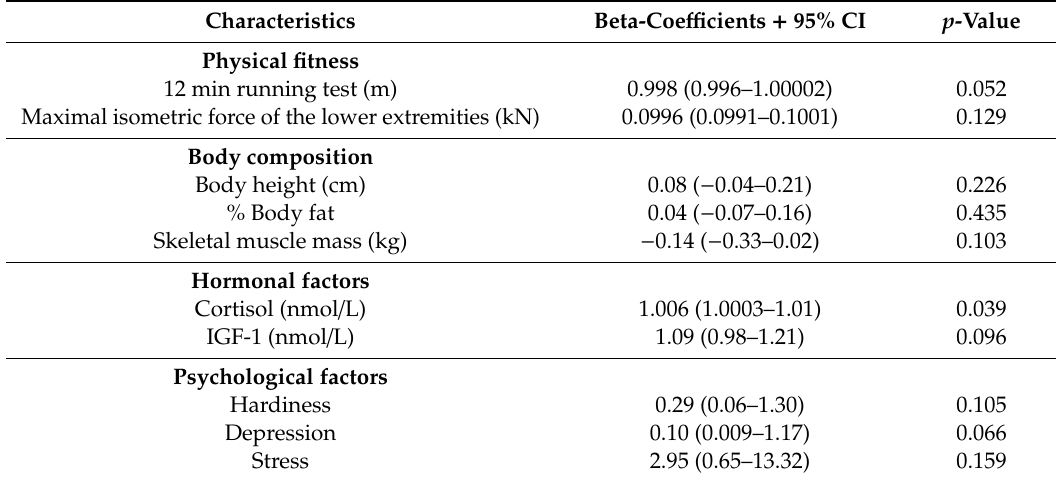
Table 3. Prediction model for dropout (Cox regressions with proportional hazard ratios) after using STEP algorithm among set of variables separately for physical fitness variables alone, body composition variables alone, hormonal variables alone and psychological factors alone.